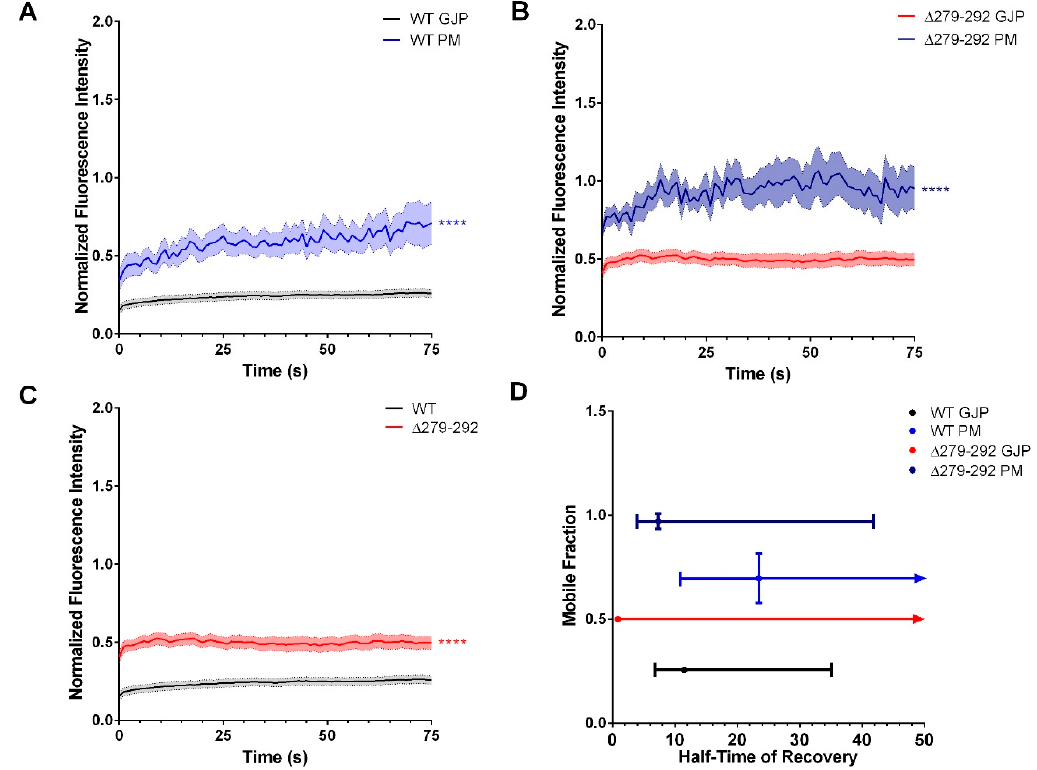
Figure 4. Cx36 connexons are initially delivered to the plasma membrane via the tubulin cytoskeleton and diffuse laterally to the GJP. Fluorescence Recovery After Photobleaching (FRAP) microscopy was